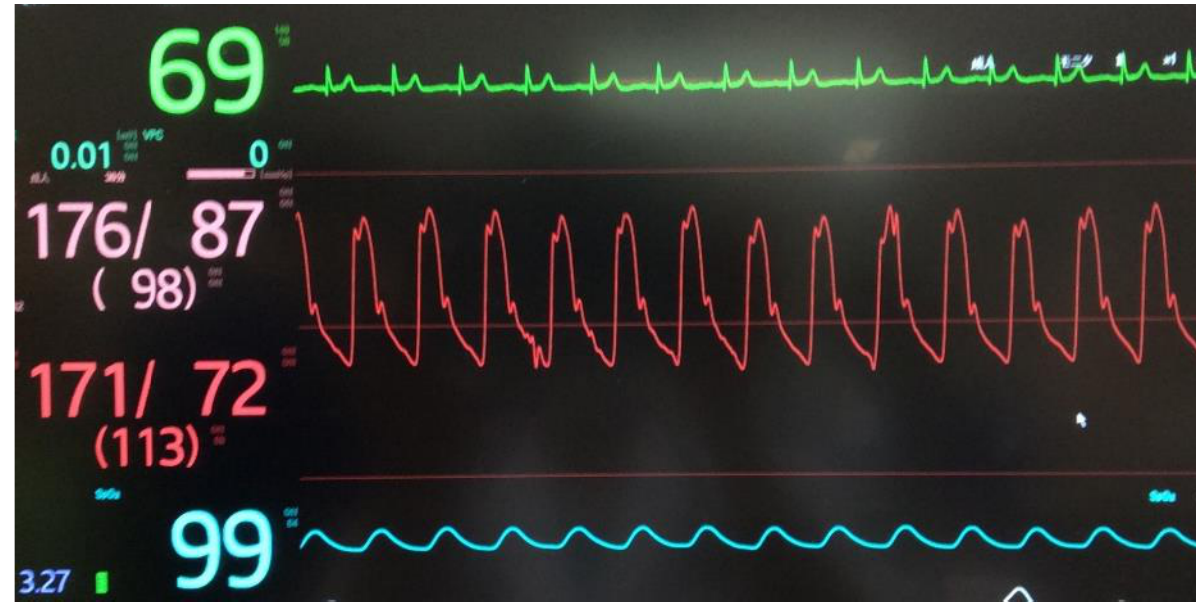
Figure 4. SpO 2 values and other vital signs after the administration of methylene blue.